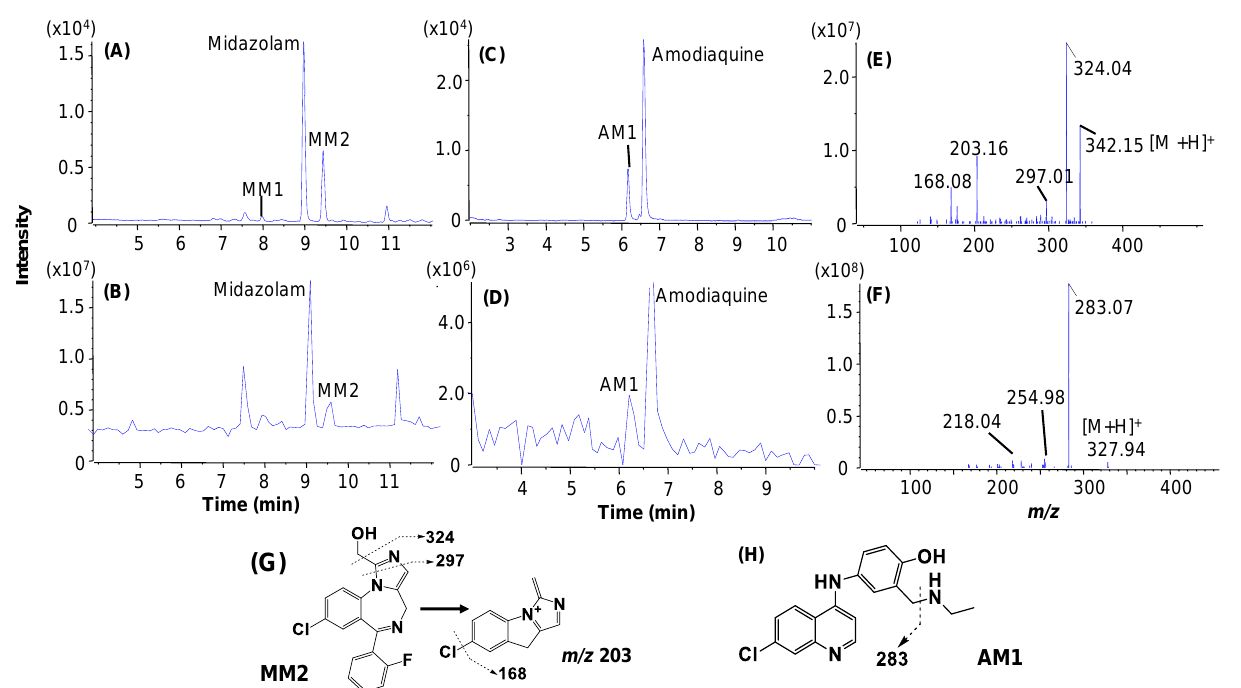
Figure 6. Metabolic soft-spot identification of verapamil (3 µM, 4 min) by LC/UV/Qtrap. ( A ) LC/UV profile; ( B ) LC/MS profile of the MIN scanning; ( C ) LC/MS profile of NLF of 290 Da; ( D ) LC/MS profile of PIF of m/z 165; ( E ) LC/MS profile from PIF of m/z 260; ( F ) MS/MS spectrum of verapamil; ( G ) major fragmentations of verapamil.